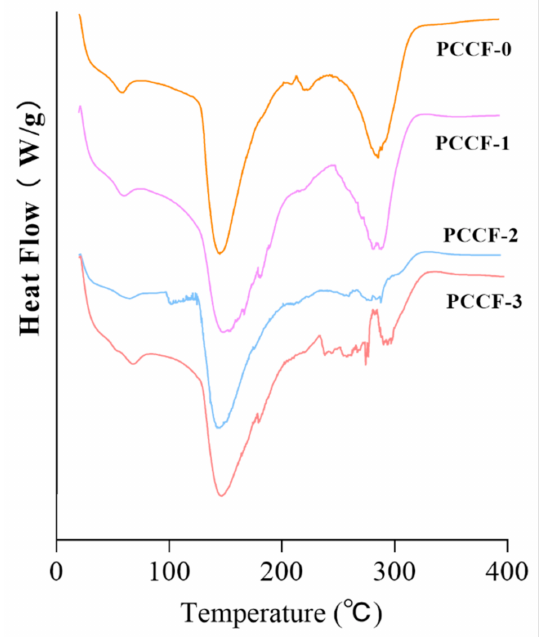
Figure 2. The DSC thermograms of